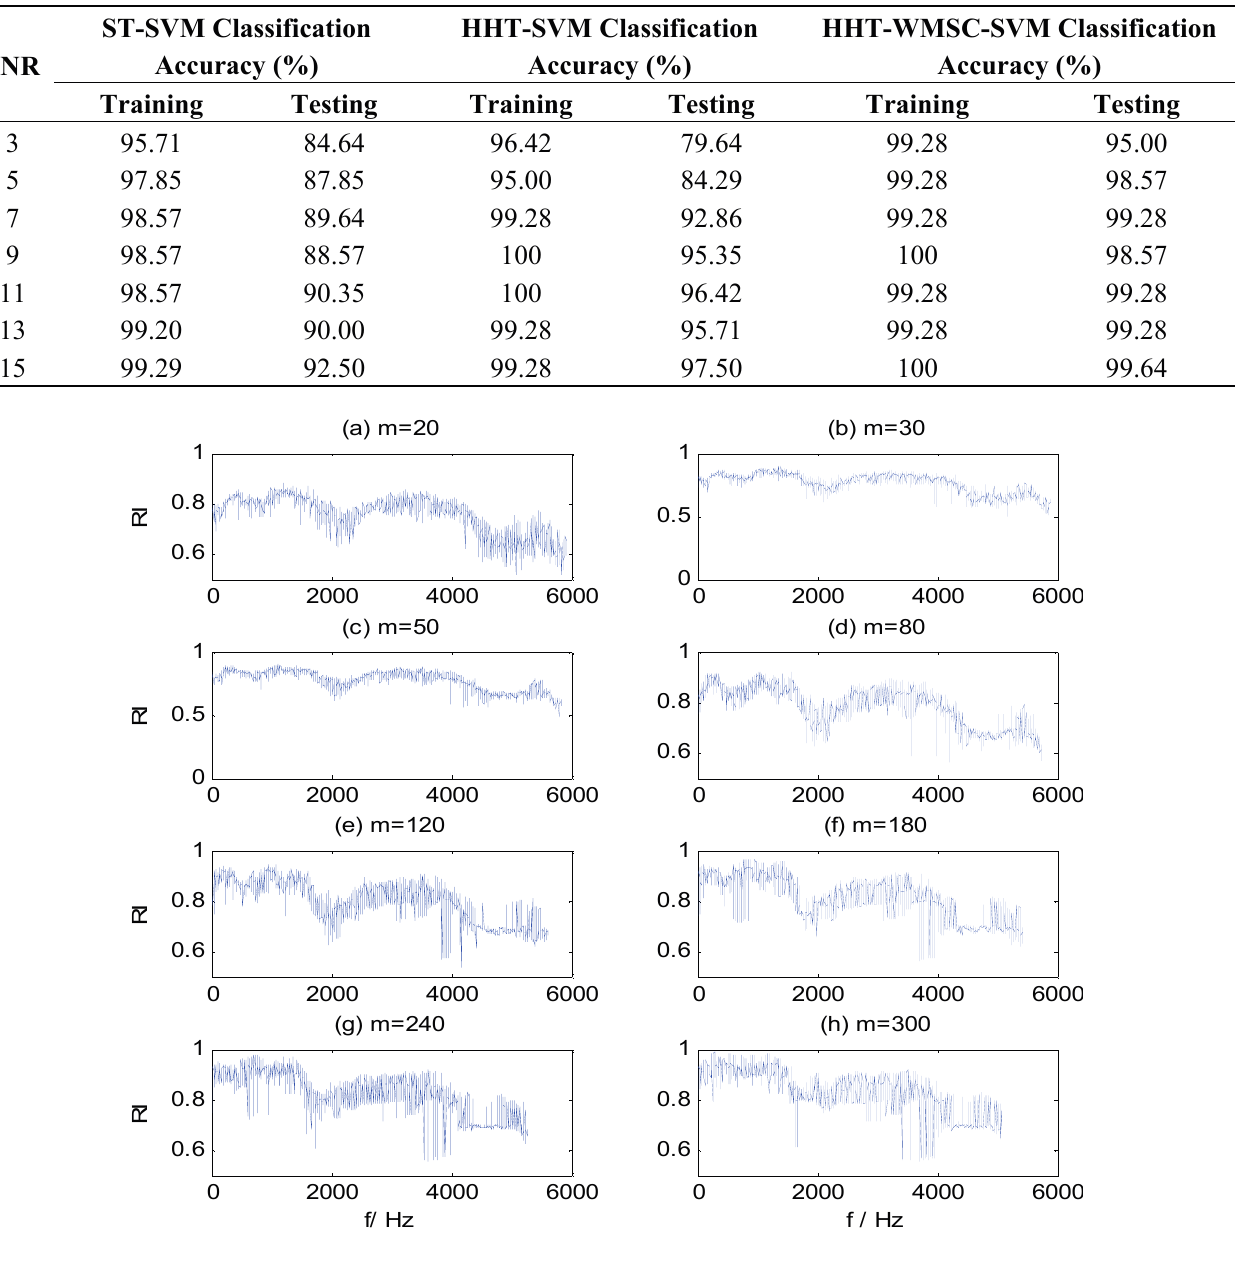
Figure 9. RI value sequences in different window sizes m for SNR = 5. ( a ) m = 20; ( b ) m =